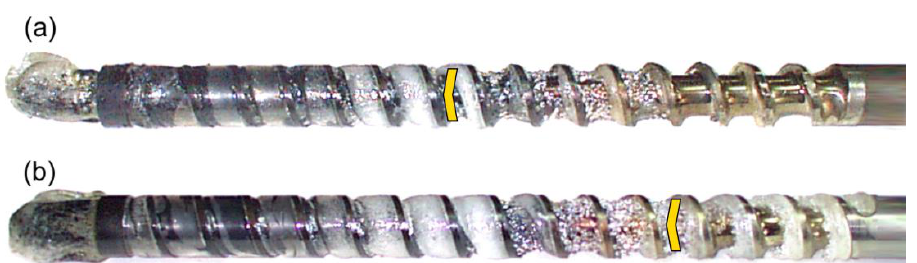
Figure 8. An effect of the screw speed on the polymer flow in the injection molding process at the plastication stroke h plast = 3 D, and the back pressure P back = 0 MPa: ( a ) N = 100 rpm, ( b ) N = 300 rpm.